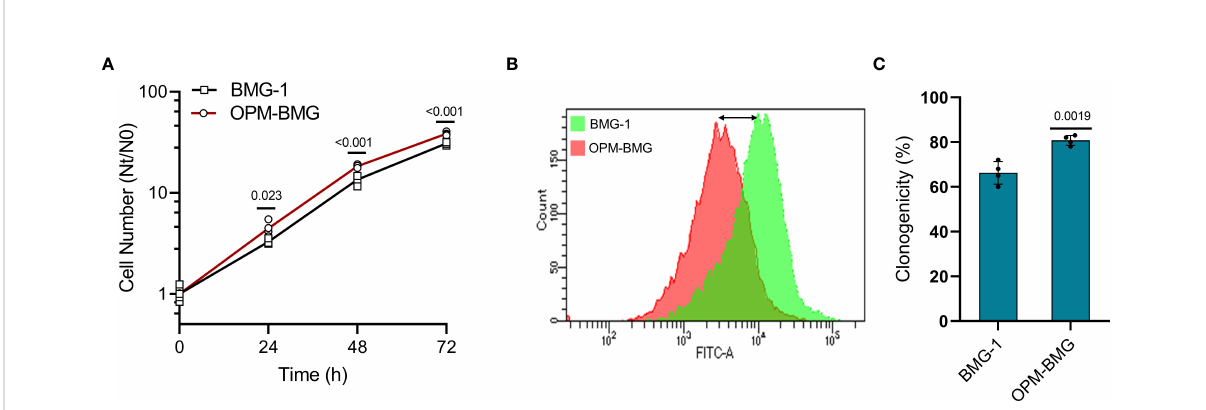
FIGURE 3 OPM-BMG cells showed an increase in cell growth and clonogenicity. (A) Growth kinetics was performed in BMG-1 and OPM-BMG cells (n=4) at indicated time points (x-axis), the exponential increase in the cell number is expressed as Nt/N0 (y-axis). (B) The 48-hour CFSE overlay graph shows the right-to-left differential fl uorescence shift in cells as a function of cell proliferation. (C) Difference in the clonogenicity is presented as percent platting ef fi ciency (%PE; n=4). Data are expressed as the mean ± SD, and P -values (BMG-1 versus OPM-BMG cells) are mentioned in the